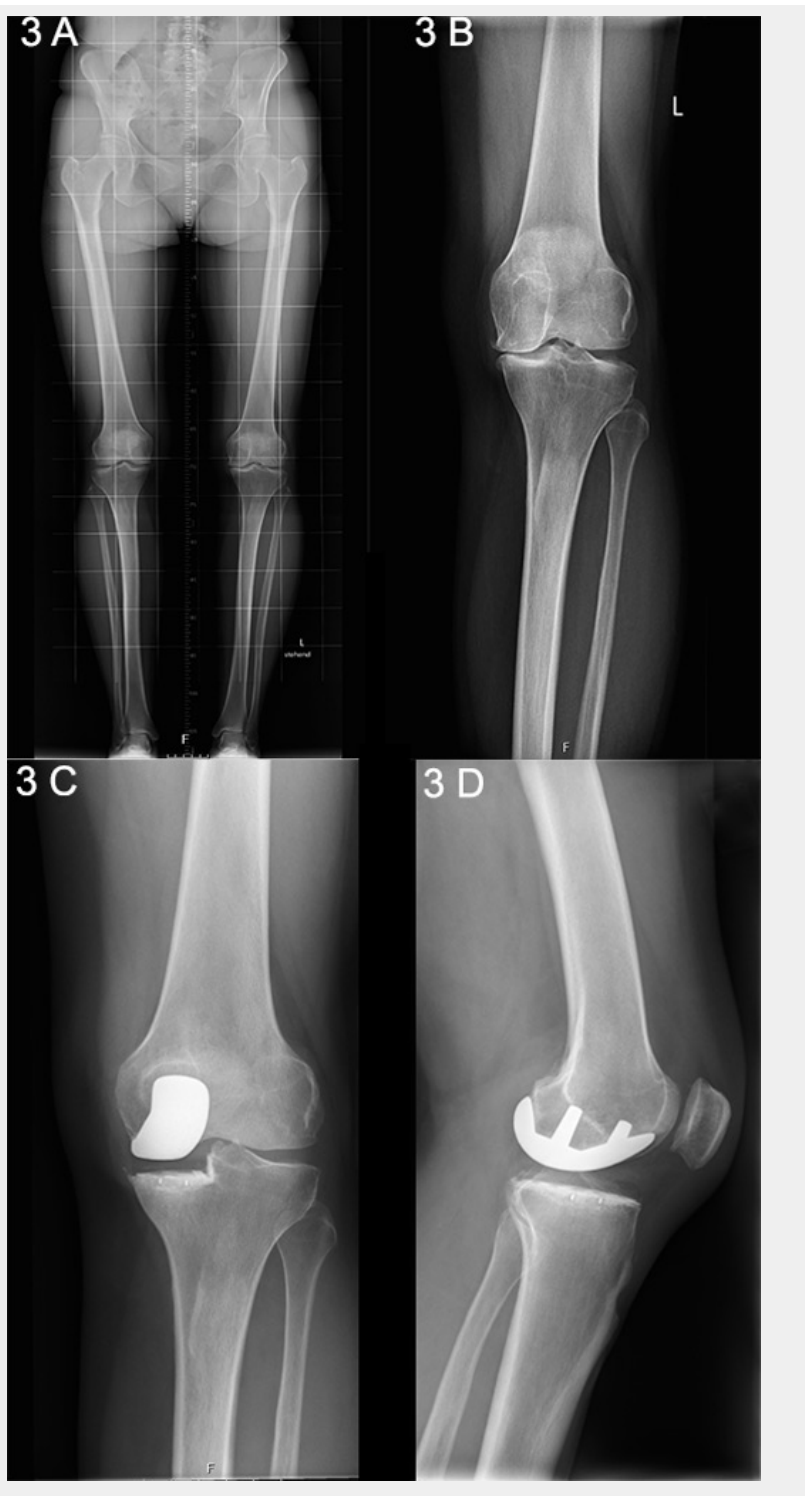
Figure 3 A. Long-standing X-ray showing unicompartmental medial knee osteoarthritis. B. Anteroposterior X-ray showing unicompartmental medial knee osteoarthritis. C. Postoperative anteroposterior X-ray following unicondylar knee arthroplasty (UKA). D. Lateral X-ray following